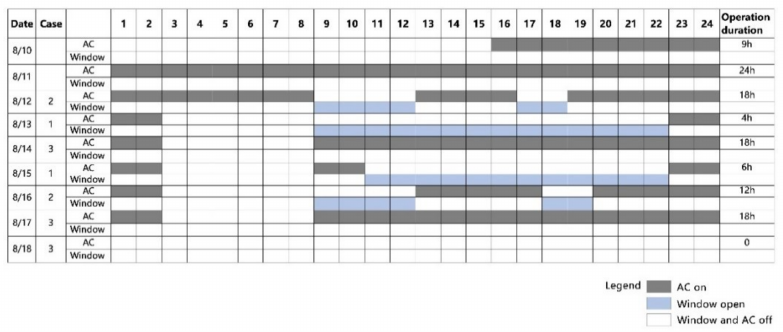
Figure 11. The operation schedule of the air conditioner and